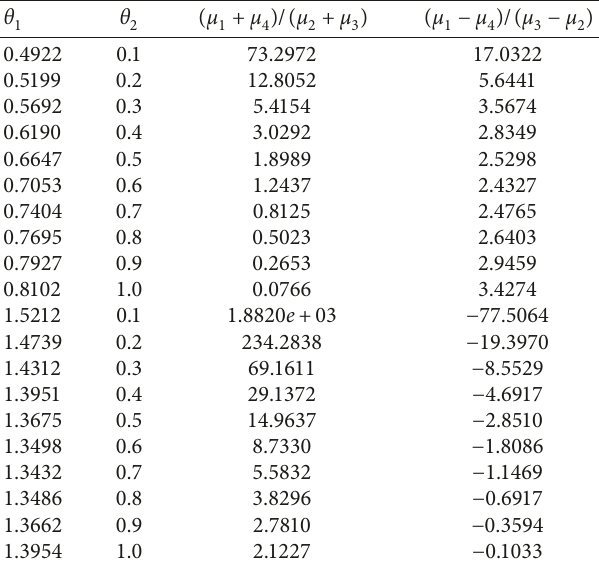
Figure 4: The only central configuration according to Theorem Table 1: Some numerical results of θ ( μ